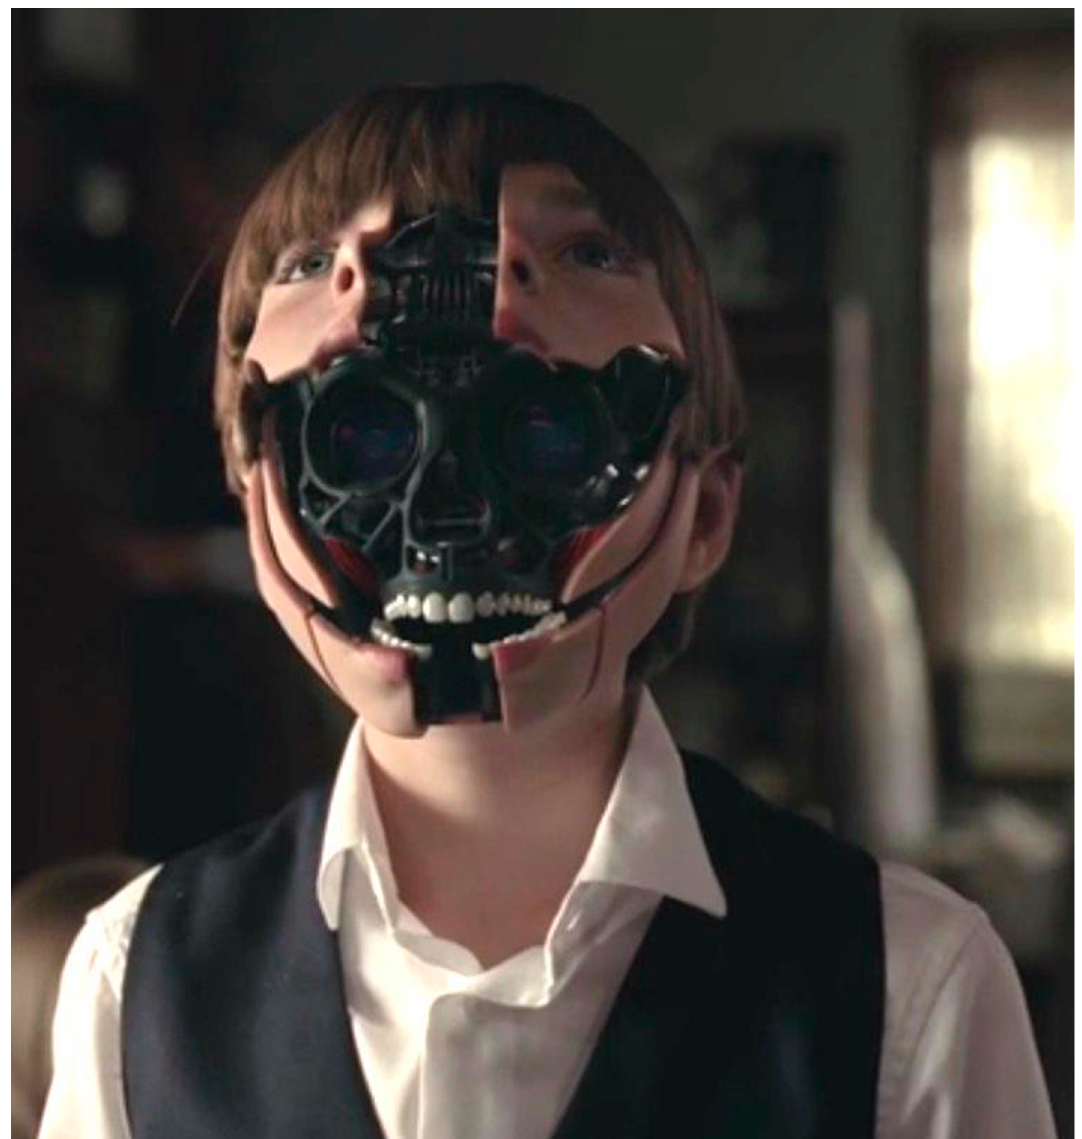
Figure 3. Still from the tv series Westworld (S01E06, 2016), produced by